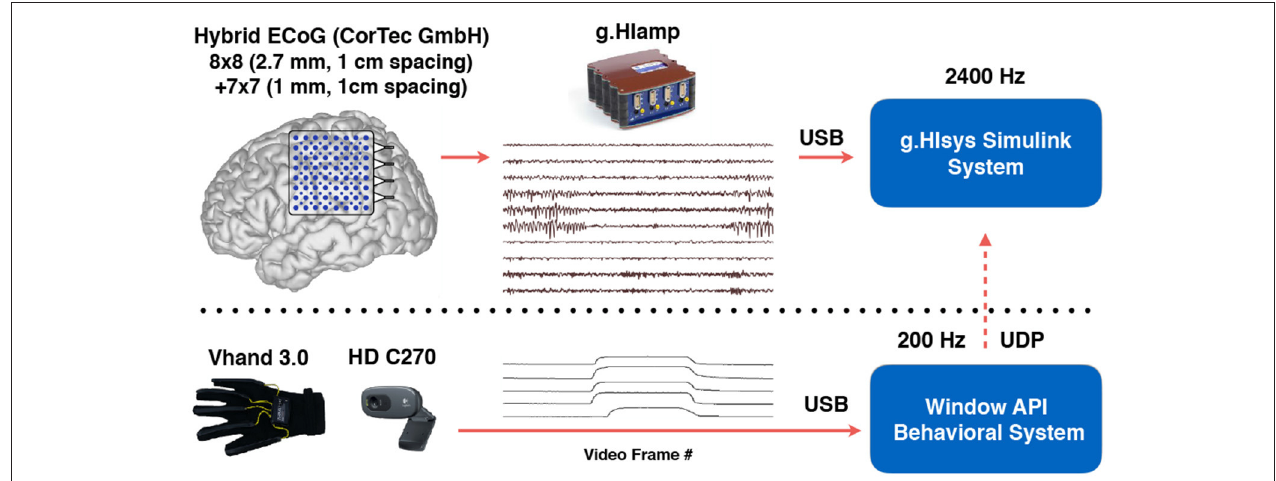
FIGURE 3 | Recording setup to collect ECoG and sensor data simultaneously. The layout of the custom hybrid ECoG grid with 113 channels was shown on a template brain surface. Video and hand position data were captured by the behavioral system and sent to g.HIsys Simulink system via UDP to synchronize with neural data (Jiang et al.,